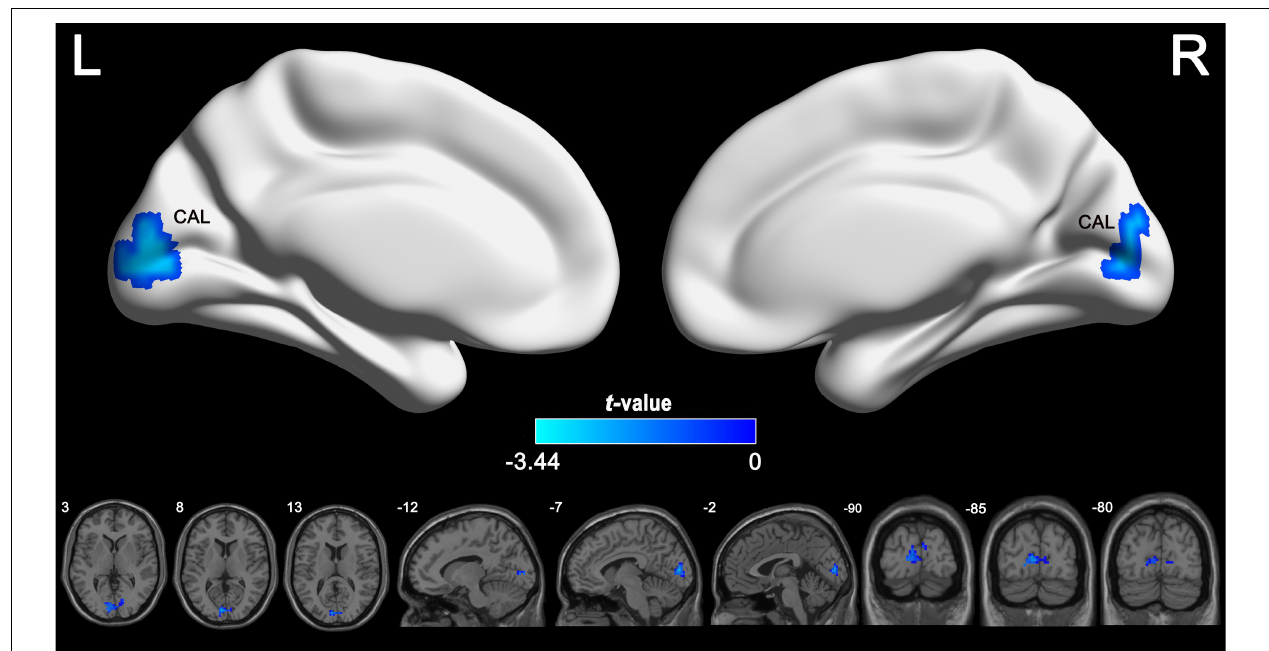
FIGURE 3 | Between-group comparisons for the seed-based functional connectivity with the seeds of left IFGtriang. The independent two-sample t test was conducted between the IGE group and HC. All results were corrected for multiple comparisons (GRF, P < 0.05). CBF, cerebral blood flow; HC, healthy controls; GRF, Gaussian random field; IGE, idiopathic generalized epilepsy. IFGtriang, inferior frontal gyrus, triangular part.